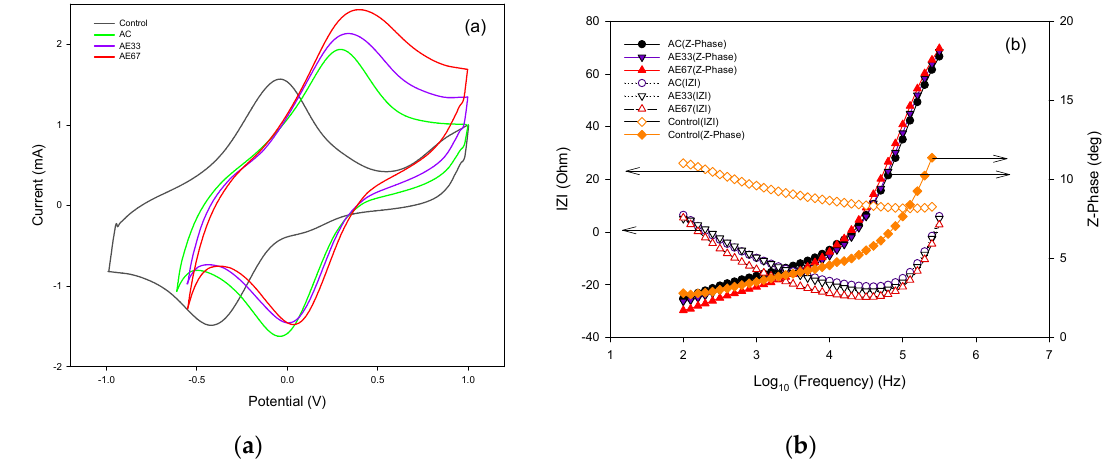
Figure 5. ( a ) Cyclic voltammogram and ( b ) Bode plots of the electrochemical impedance spectra of the bulk solutions of the anaerobic batch reactors.